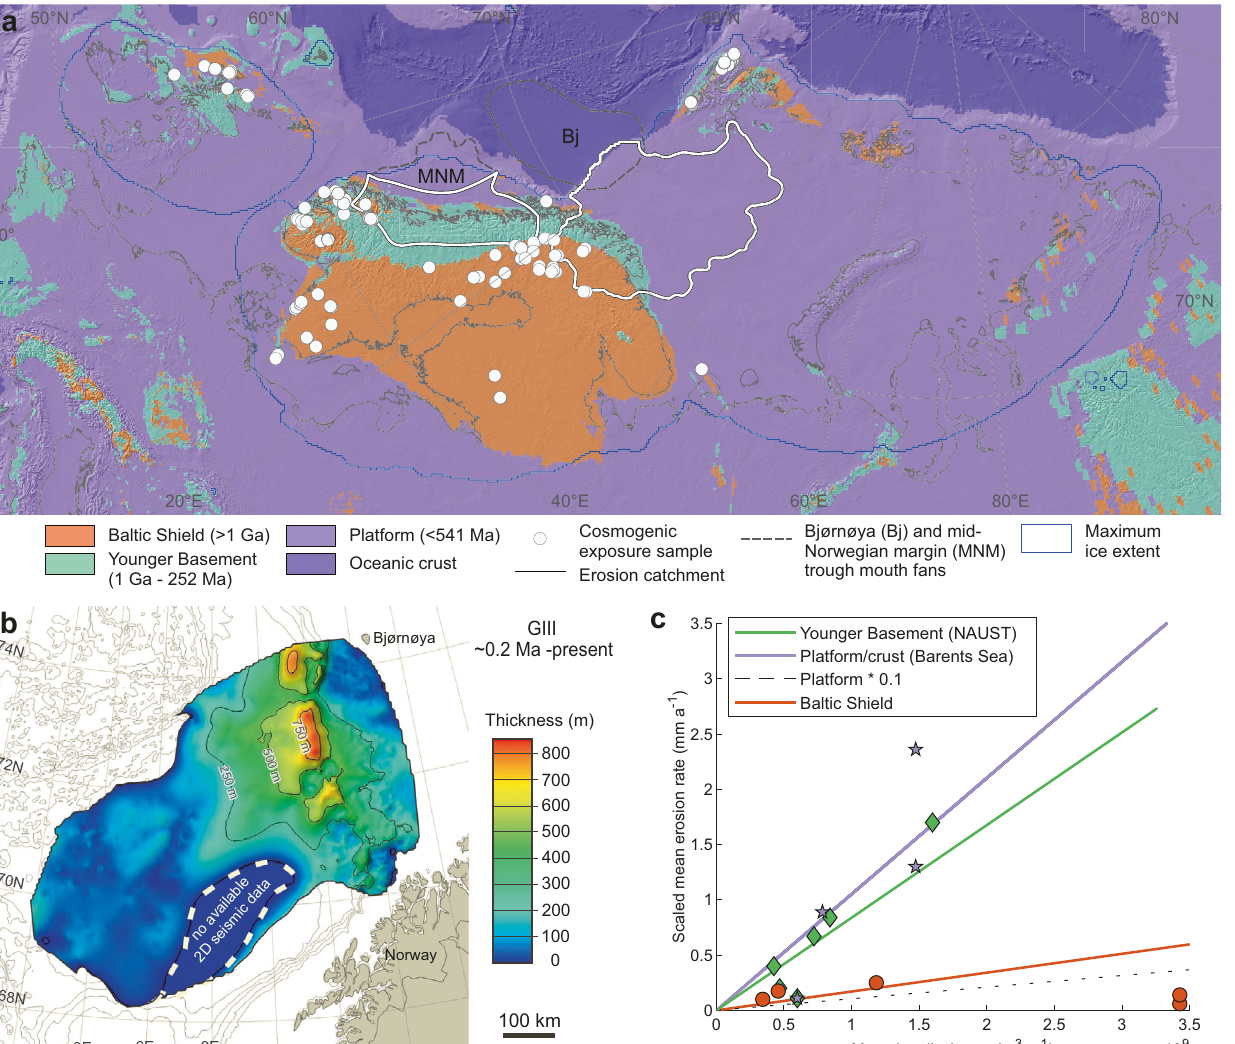
Fig. 2 | Geological provinces and erosion modelling constraints. a Geological provincesof the Eurasiandomain, delimited by ageand rocktype according tothe IGME 5000 102 and GLiM datasets 103 . Cosmogenic exposure samples taken from bedrock ( n =249) were used to constrain glacial erosion rates over the Shield province (Supplementary Data 1). Trough mouth fan catchments, de fi ned from ice modeloutputs,delimittheareasforbackstackingglacialsedimentsintheYounger Basement (mid-Norwegian Margin) and Platform (Bjørnøyrenna) provinces. b Thickness map of the GIII glacial unit in the Bjørnøya trough mouth fan, derived